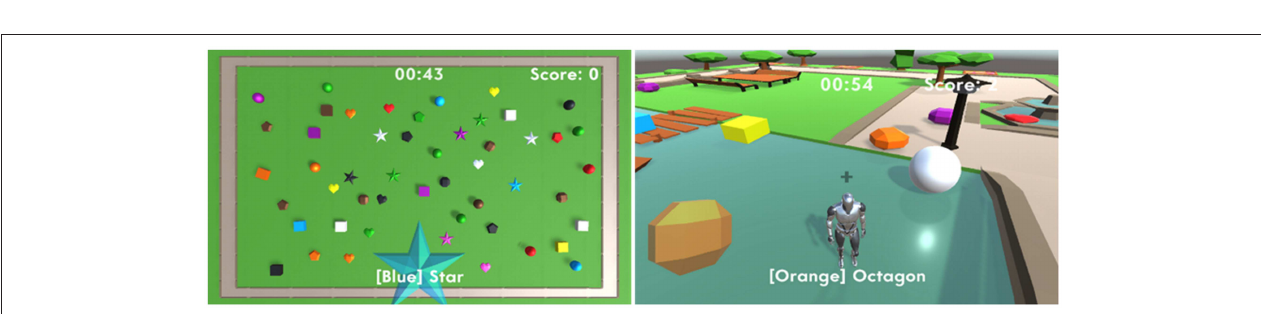
FIGURE 3 | The Highlights assistance technique. A highlighted pink pentagon in the top-down game ( left ), and in the third-person game (rising pink smoke in the distance; right ).